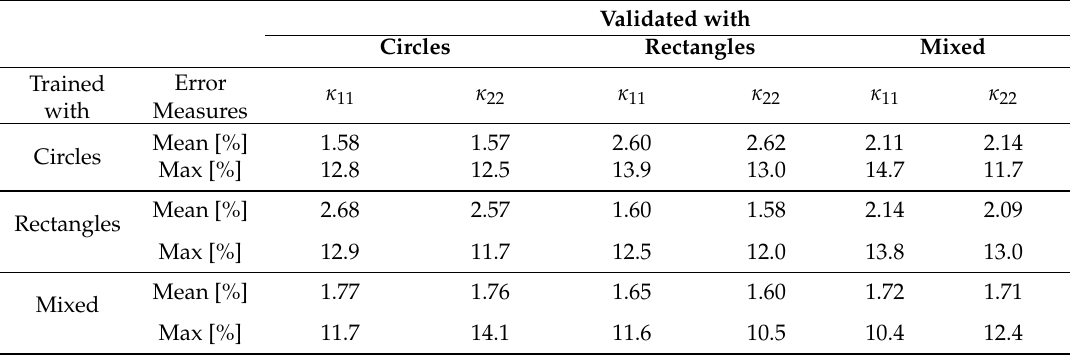
Table 2. Percentage errors for ¯ κ 11 and ¯ κ 22 given for each of the best ANNs, evaluated over the complete test set (7500 data